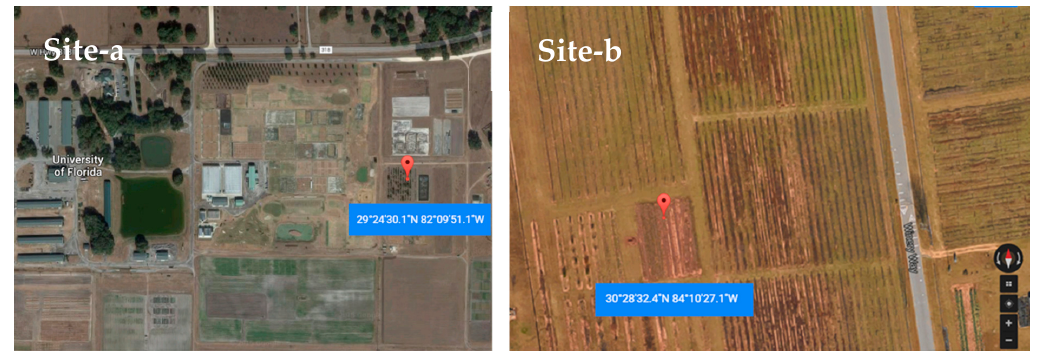
Figure 1. Site-a—monitoring site for Drosophila suzukii at the Plant Science Research and Education Unit, University of Florida, Citra, FL. Site-b—the Center for Viticulture and Small Fruits Research, FAMU, Tallahassee, Florida. Photo source: Google maps.